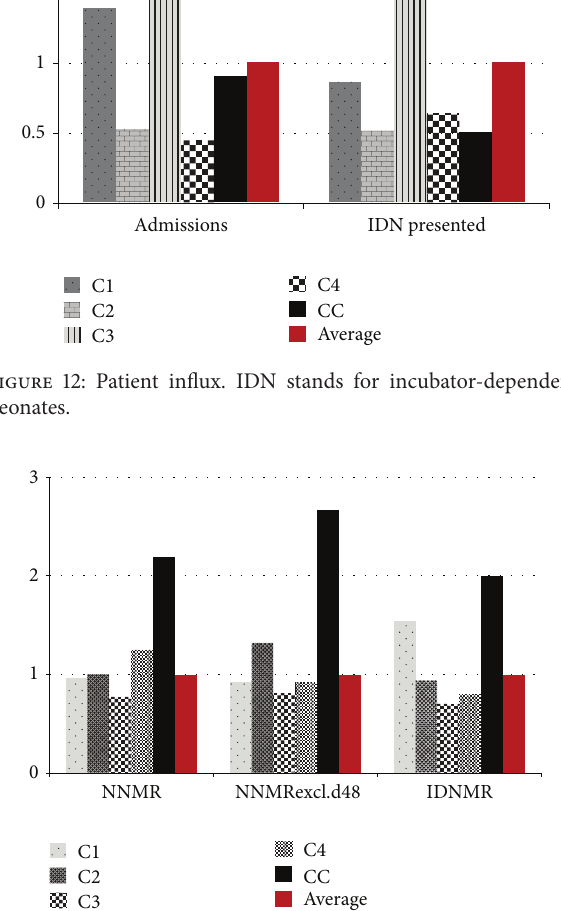
Figure 13: Performance indices comparison across all centres. NNMR stands for neonatal mortality rate, NNMRexcl.d48 for neonatal mortality rate excluding babies dying within 48 hours of presentation, and IDNMR for incubator-dependent-neonate mortality rate.